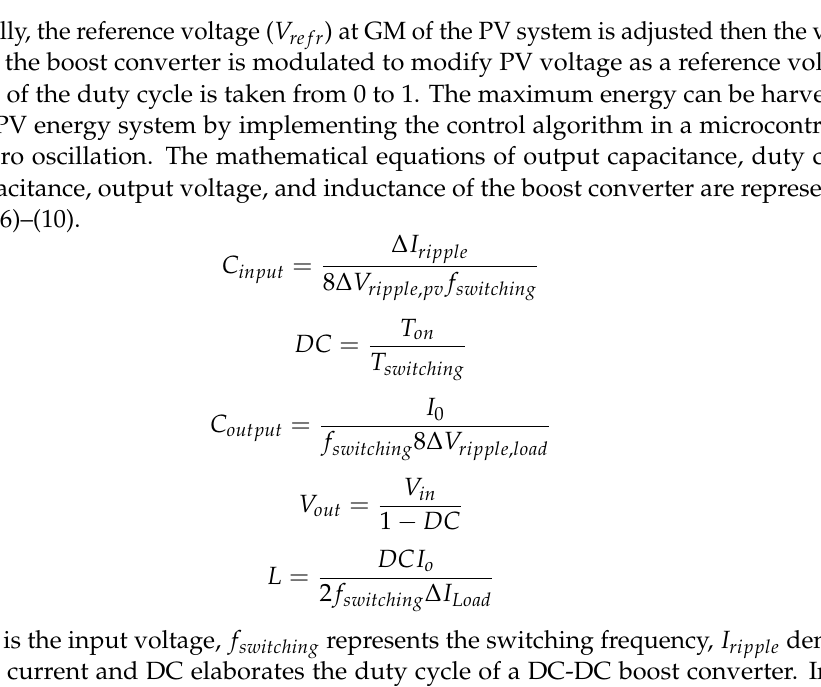
Figure 2. DC to DC Boost-Converter In PV